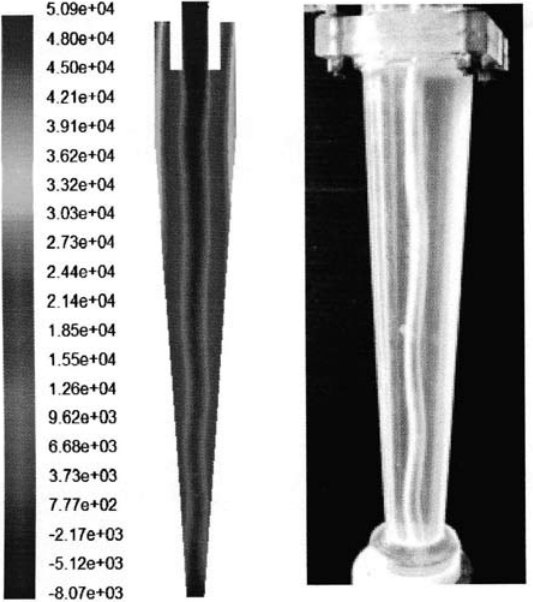
Fig.4 The obtained pressure (Pascal) of fluid projected on a vertical plane of the hydrocyclone: a) operating with an air core, b) experi- mental observation (Kraipech et al .,